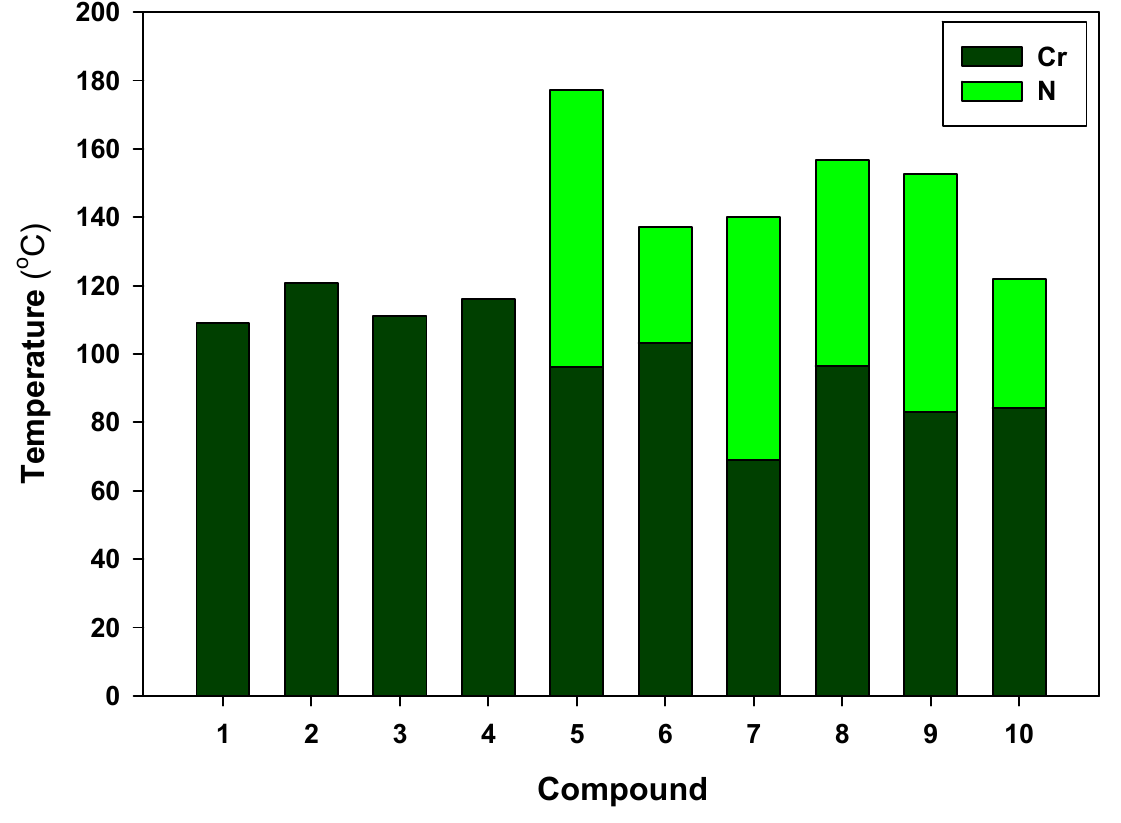
Figure 3. DSC transitions for investigated compounds 1 – 10 .